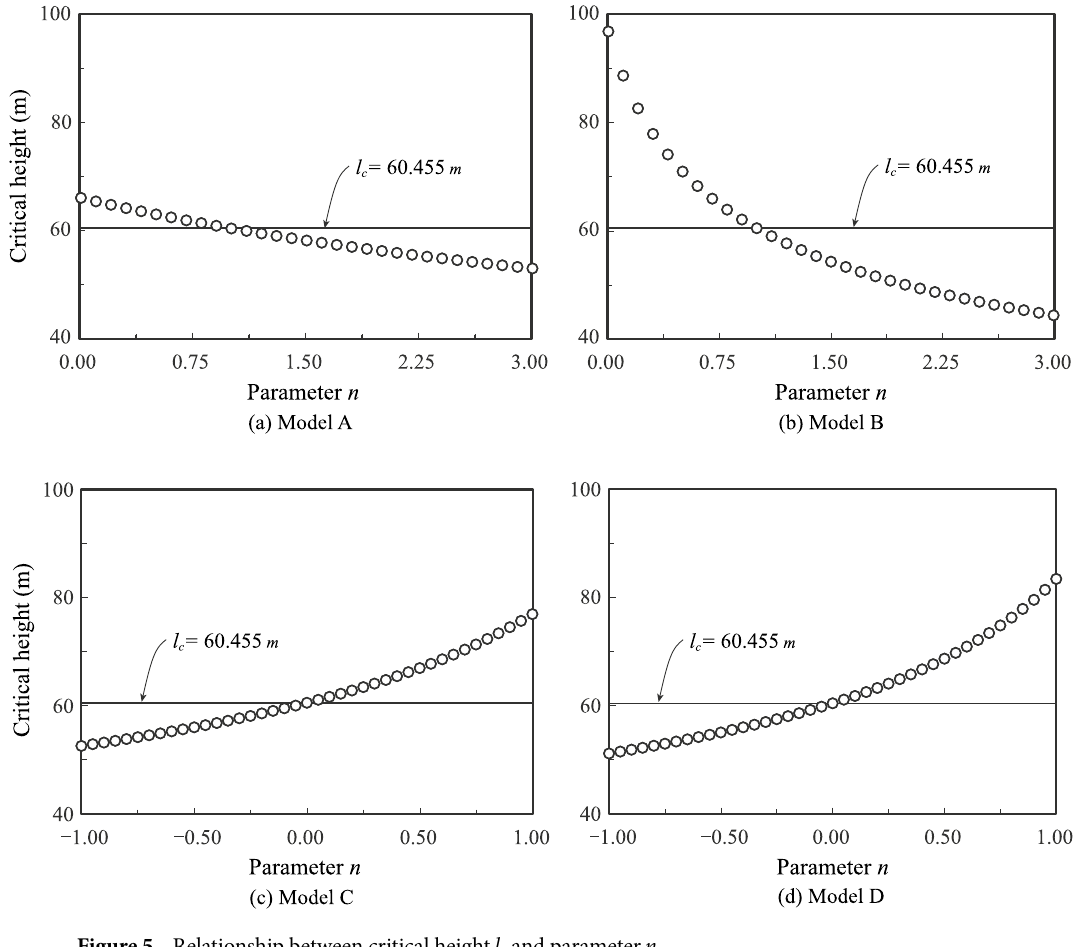
Figure 5. Relationship between critical height l c and parameter n